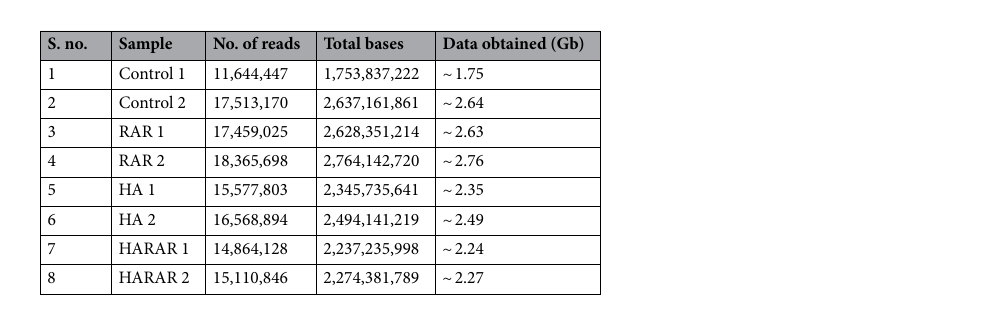
Table 1. Read statistics of transcriptome of different